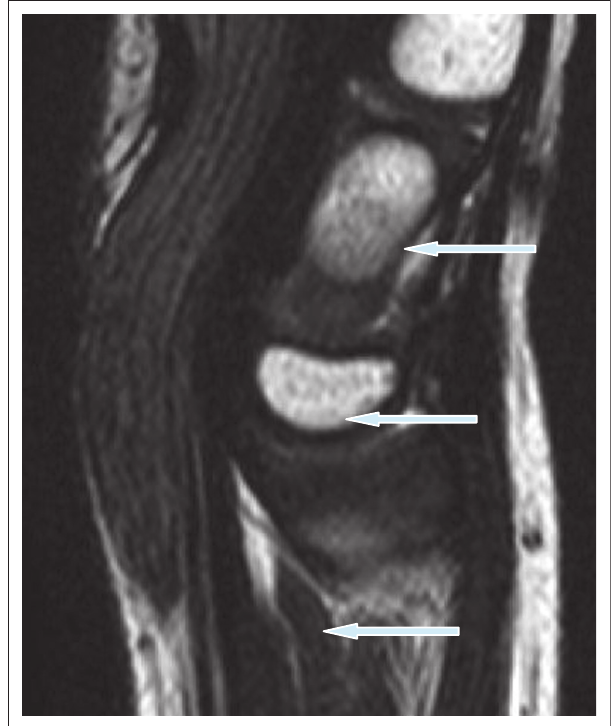
FIGURE 4: T1WI sagittal MR image demonstrates fusiform enlargement of the slightly hyperintense median nerve fascicles with a characteristic ‘ spaghetti-like’ appearance (white